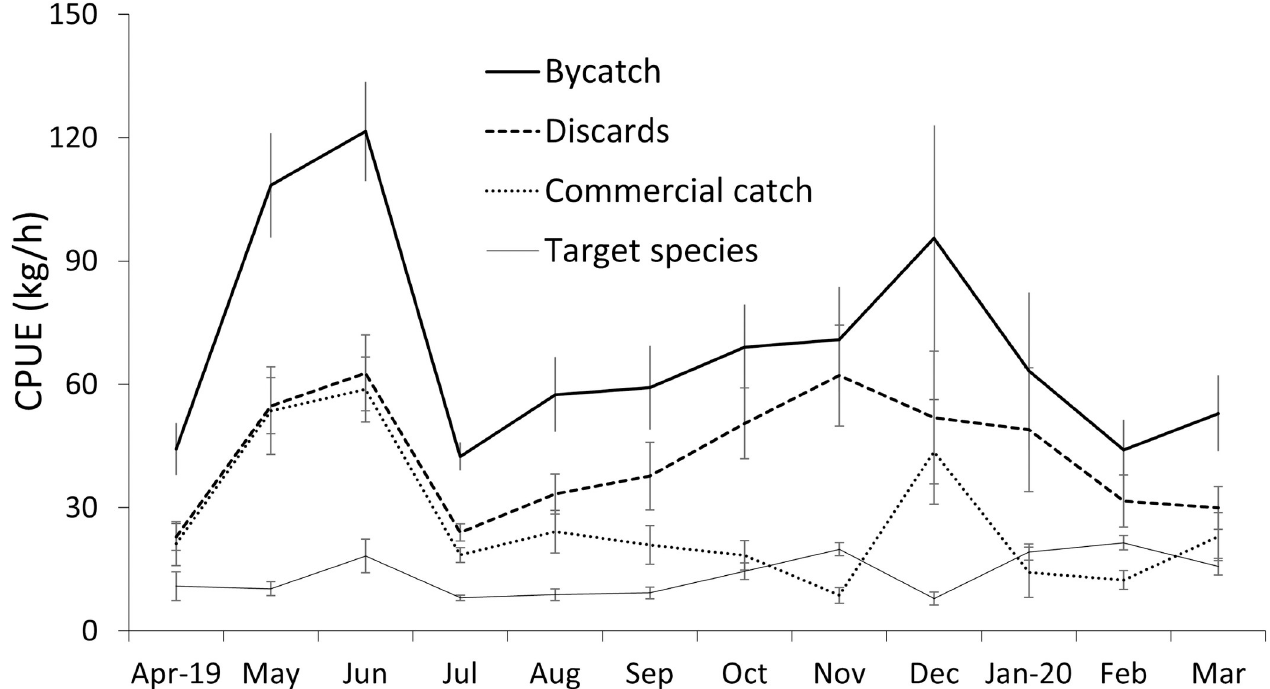
Fig 3. Monthly variation of the average CPUE (kg.h -1 ) of bycatch, discards, target species, and commercial species caught by the shrimp trawlers between Cabo Blanco and Ma´ncora, April 2019-March 2020. Error bars represent standard errors.